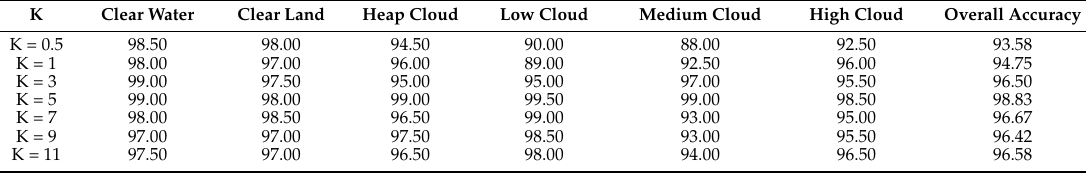
Table 4. Classification accuracy (%) of different cloud types by AFSRC using different value of K. K Clear Water Clear Land Heap Cloud Low Cloud Medium Cloud K = 0.5